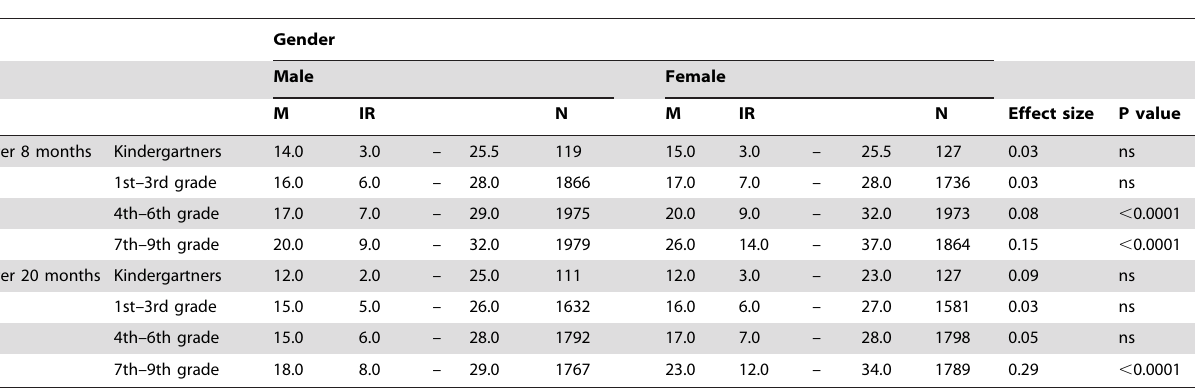
Table 3. Average PTSSC-15 score (grade and